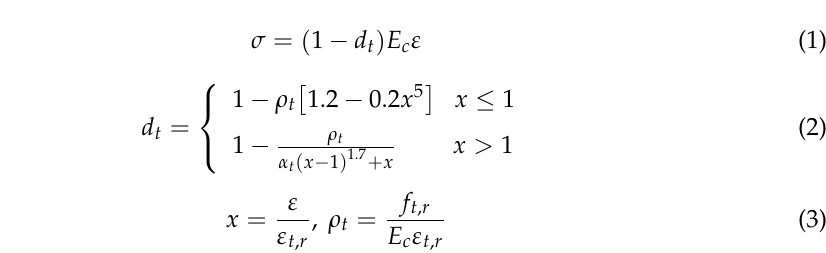
Figure 5. Constitutive curve of the concrete-damaged plasticity model.